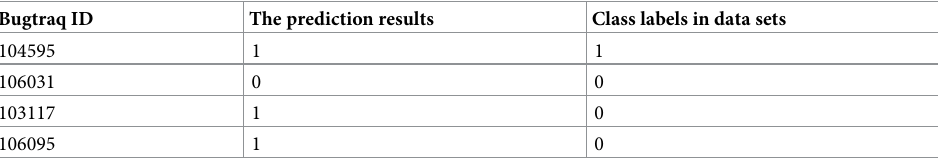
Table 8. Sampling prediction results of fastEmbed